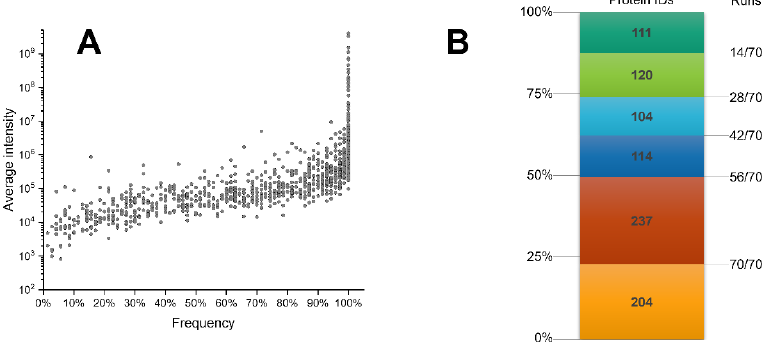
Figure 5. Identification sensitivity and reproducibility. ( A ) Correlation between the frequency of identification of each protein over the 70 runs and its average intensity. ( B ) Stacked, colored boxes represent the identification frequencies over the 70 runs.